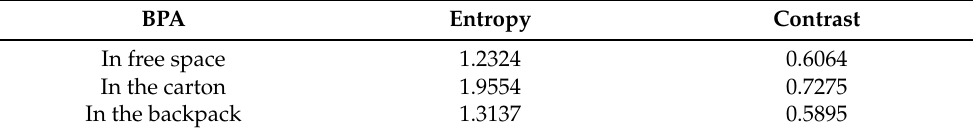
Figure 7. Imaging results in different environments. Column 1 is a pistol in a normal environment; Column 2 is a pistol in the carton; Column 3 is a pistol in the backpack; Row 1 are the optical images of the target; Row 2 are 2-D BPA imaging results; Row 3 are 3-D BPA imaging results. Table 3. Quality evaluation of imaging results in different